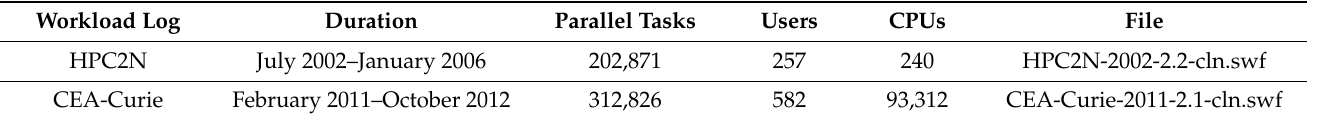
Table 2. Description of real